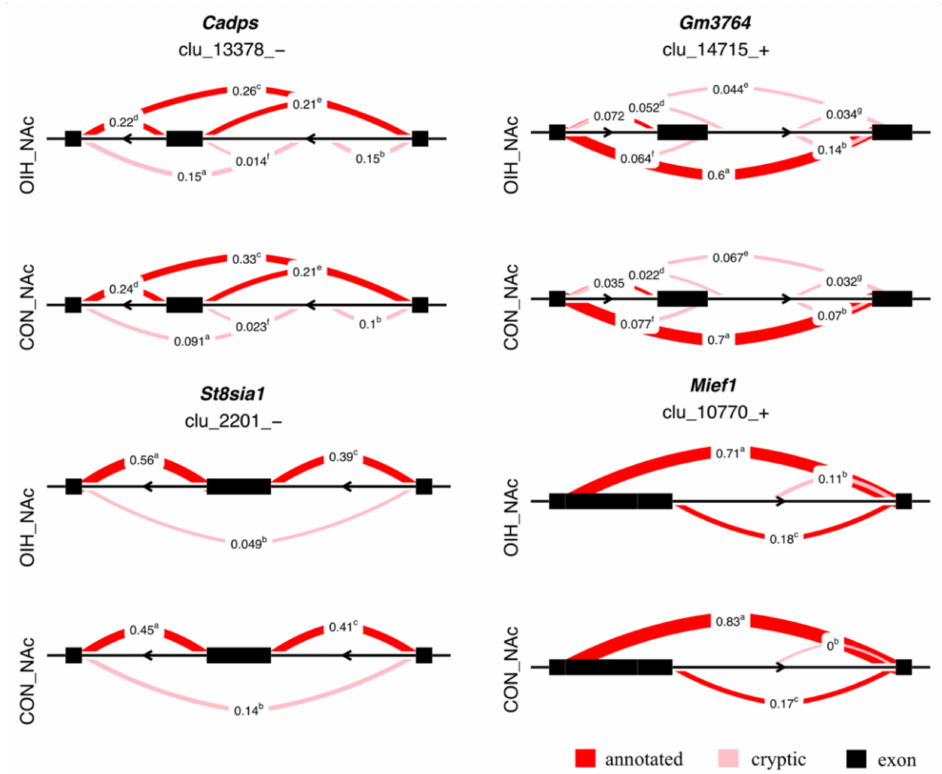
Figure 1. Examples of differential spliced genes (maximum | ∆ PSI| > 0.1, P -value < 0.005) between opioid-induced hyperal- gesia (OIH) and control (CON) mice in the nucleus accumbens (NAc). Genes included Cadp =calcium dependent secretion activator, GM3764=long intergenic non-coding RNA; St8sia1=ST8 alpha-N-acetyl-neuraminide alpha-2,8-sialyltransferase 1; Mief1=mitochondrial elongation factor 1. The semicircles indicate the clusters of introns corresponding to transcript isoforms, the numbers represent the relative proportion of each intron cluster within OIH and control, and the superscript denotes different